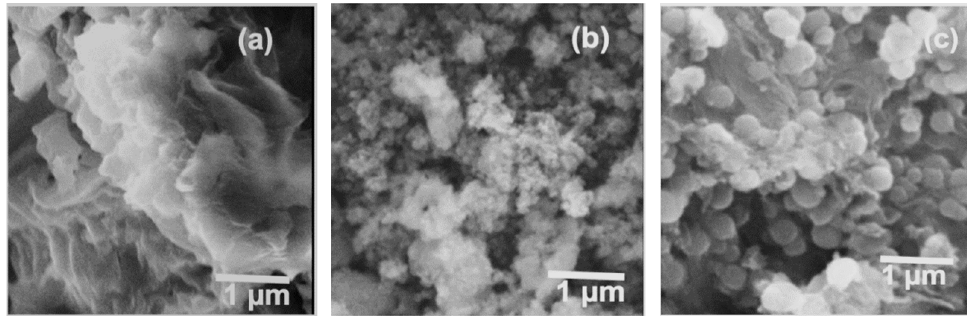
Figure 4. SEM images of ( a ) GO ( b ) Mn x Zn 1 − x O and ( c ) GO-Mn x Zn 1 − x O.